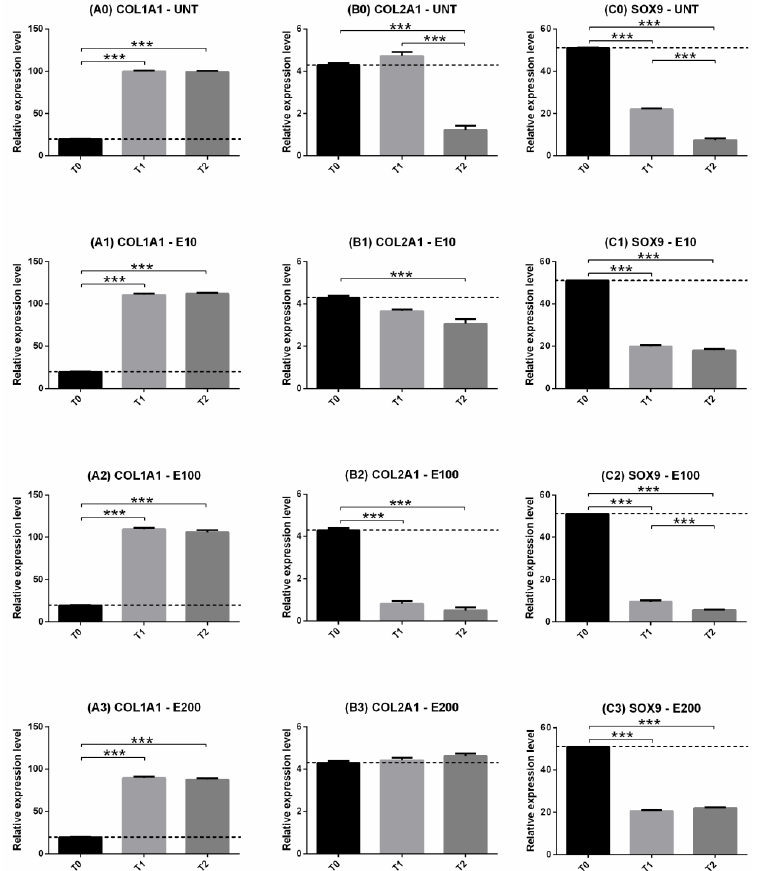
Figure 6. Gene expression the day of seeding (T0), after 9 days (T1) and after 21 days (T2) in culture: COL1A1 ( A0 – A3 ), COL2A1 ( B0 – B3 ), SOX9 ( C0 – C3 ). Two-way ANOVA and Tukey’s multiple comparisons test were performed. N = 4; *** = p < 0.001. Data were expressed as mean ± S.E.M. The dashed black line was the expression level corresponding to T0.